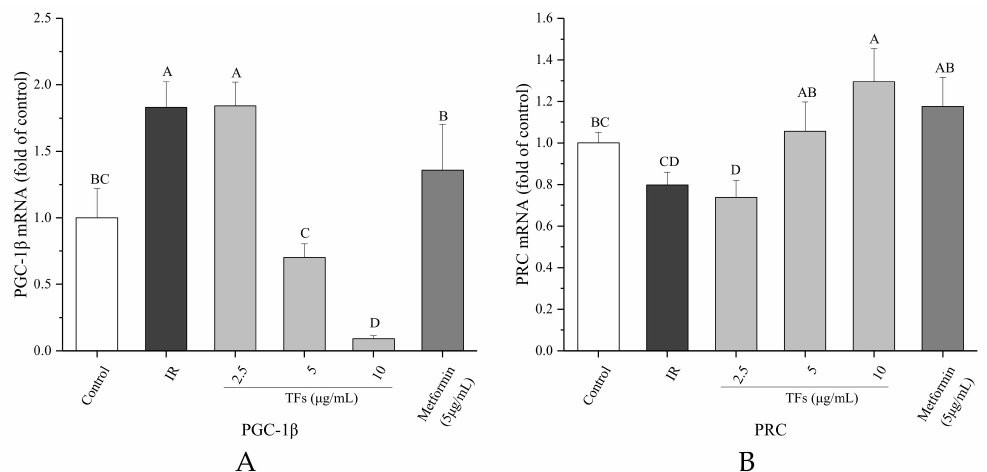
Figure 8. Effects of theaflavins (TFs) on the PGC-1 β ( A ) and PRC ( B ) mRNA expressions of insulin-resistant HepG2 cells induced by PA after 24h treatment. The relative mRNA levels (PGC-1 β and PRC) were determined by quantitative real-time PCR assay and calculated by the mean value with the comparative Ct method ( ∆∆ Ct). Data were represented as means ± SD from three replicates. Significant differences between different treatments are showed by different letters ( p <